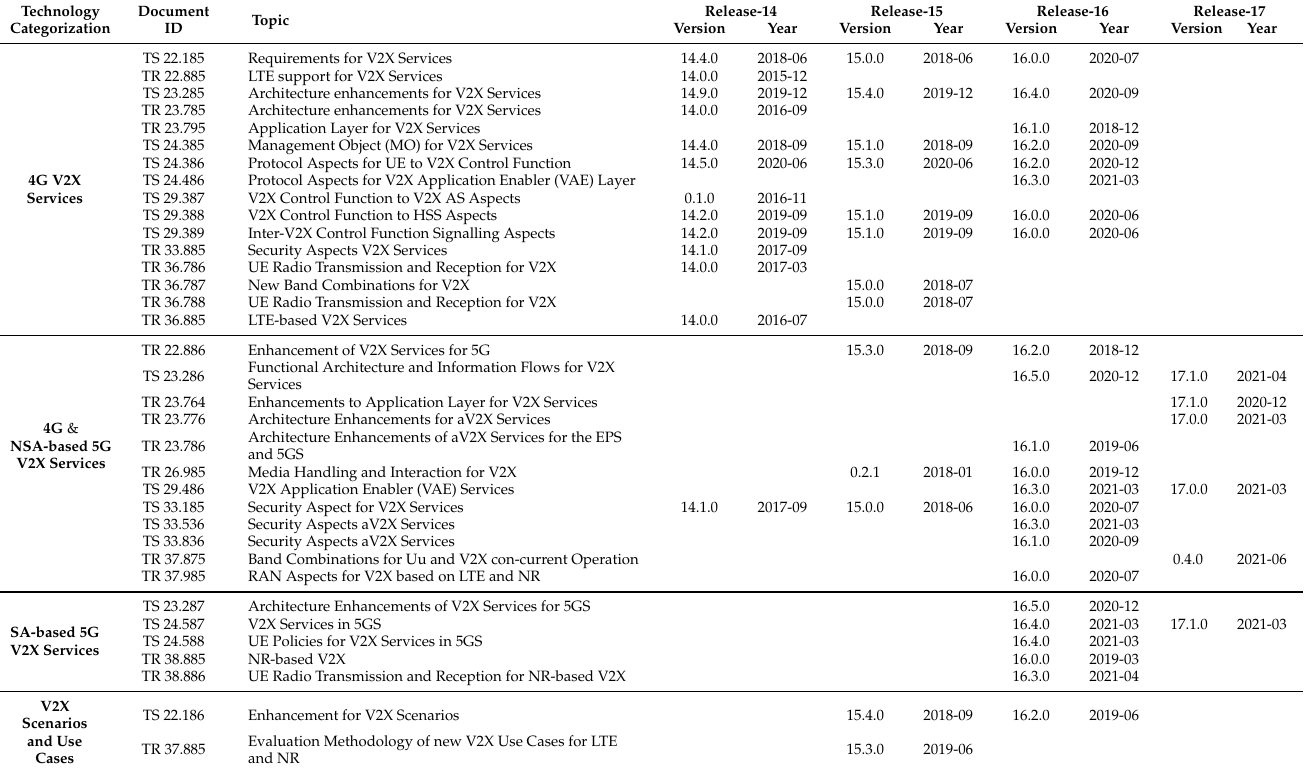
Table 1. 3GPP Standardization Support for C-V2X